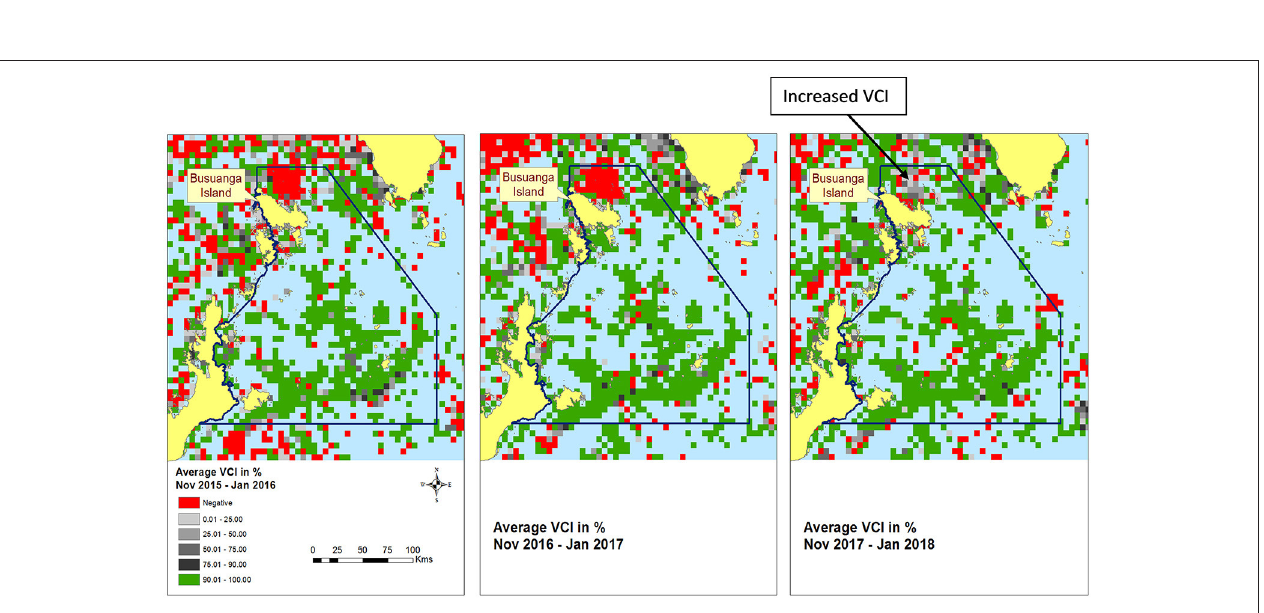
detected by the VCI and in most months the compliance rate was over 75%. Compliance dropped for two-to-three month each year: June-August, 2014; July-September, 2015, and July-August,